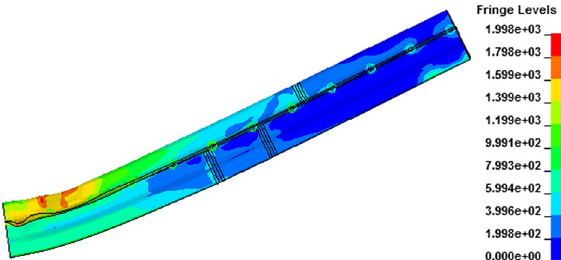
Fig 15. Influence of Type III seam weldings location on distribution of stresses of MS 1400 steel